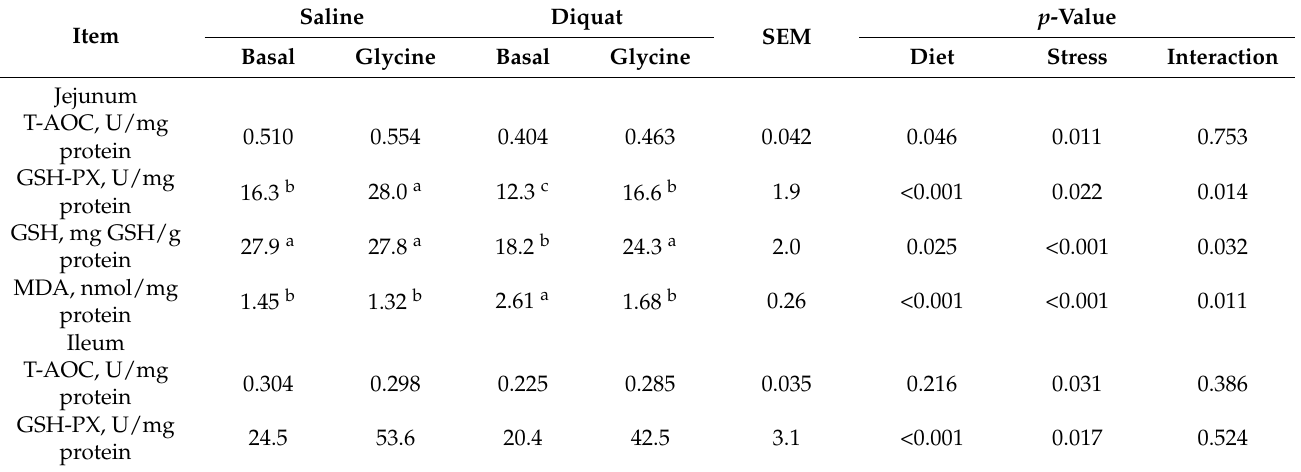
Table 5. The intestinal mucosal antioxidative capacity of the piglets fed glycine diets under oxidative